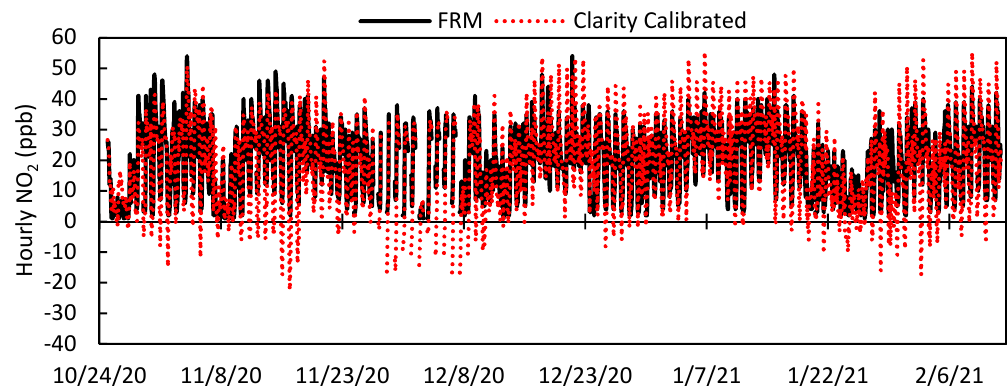
Figure 6 . Time series of hourly West Phoenix FRM NO 2 and LCS #2 Clarity 15 − Day calibration NO 2 values for the entire deployment period.